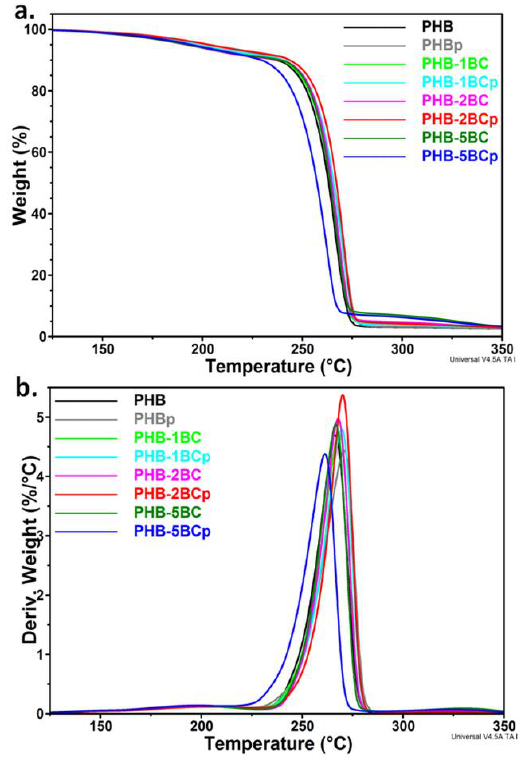
Figure 2. TGA ( a ) and DTG ( b ) curves of PHB nanocomposites with different BC content before and after the plasma treatment.